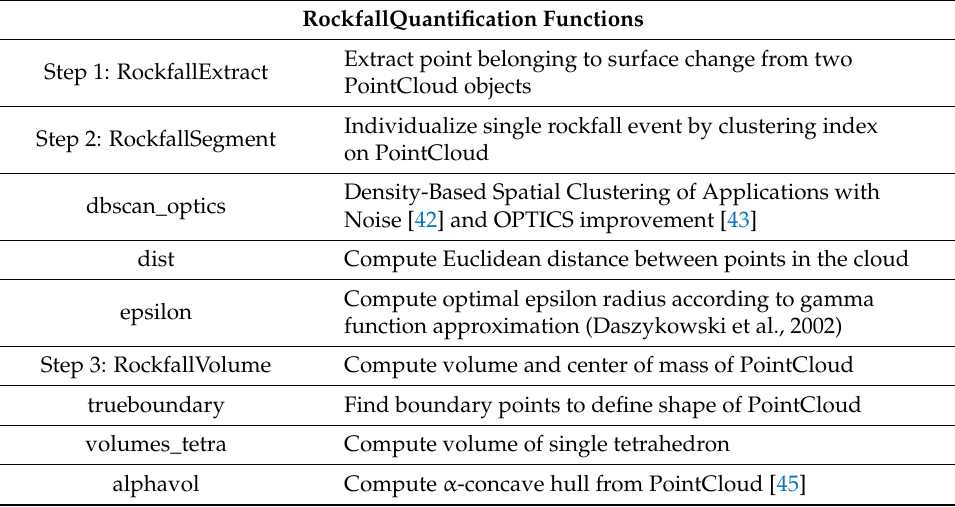
Table A1. Functions available on the RockfallQuantification package.